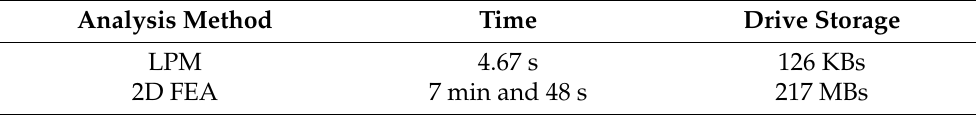
Table 3. Computational time and drive storage